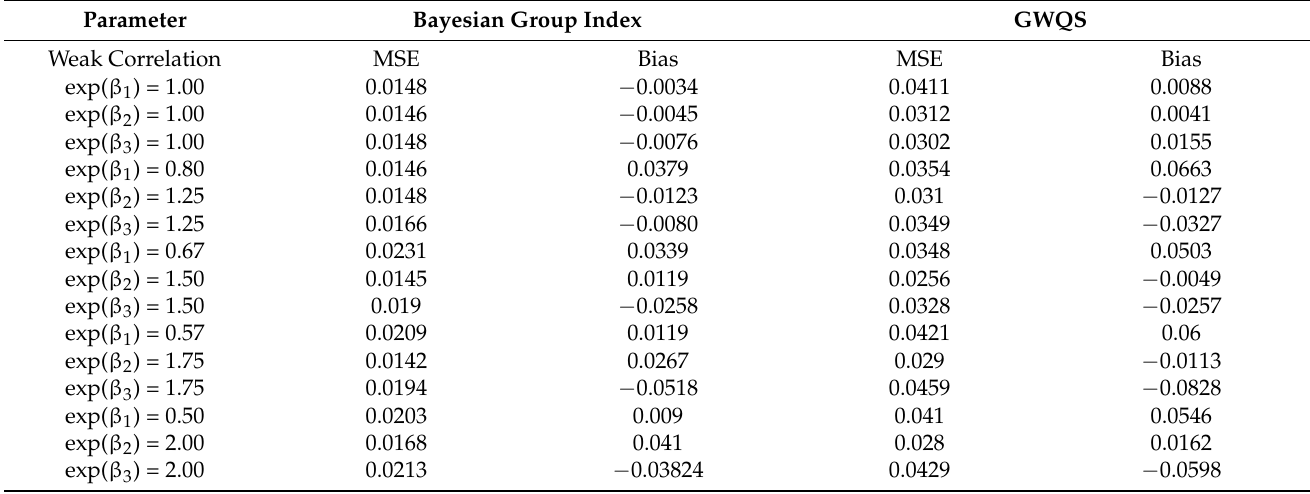
Table 3. MSE and bias for effect estimates from the Bayesian group index model and group weighted quantile sum (GWQS) regression for Scenario